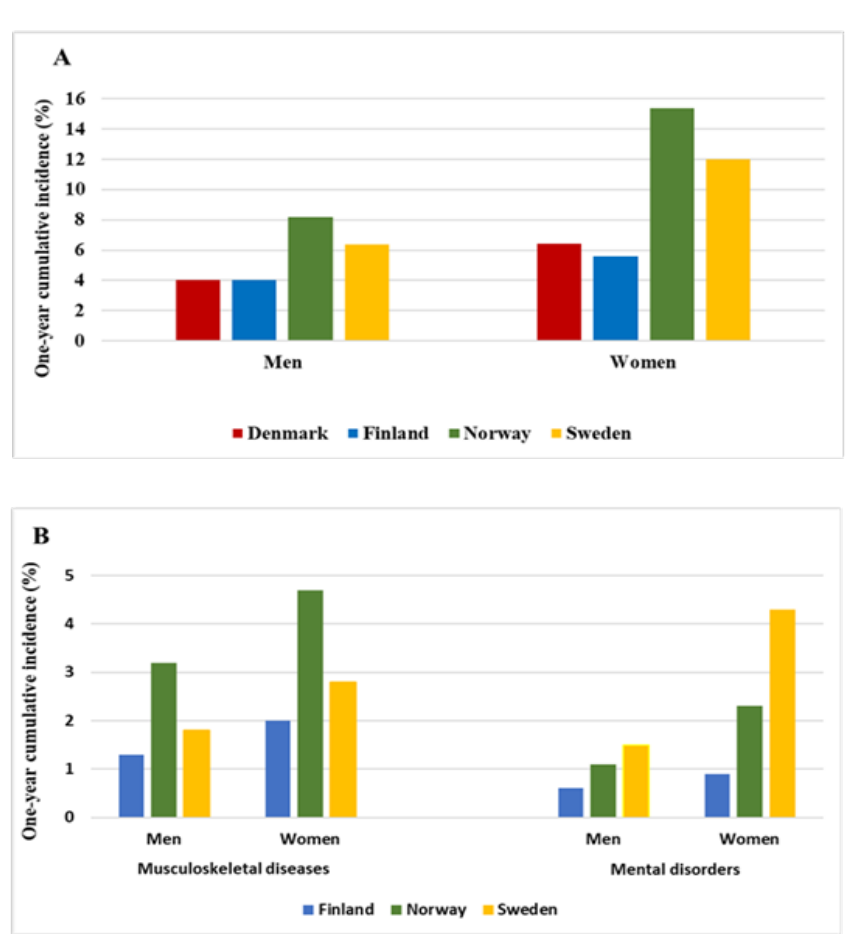
Figure 1. Age-adjusted one-year cumulative incidence of sickness absence among men and women by country, ( A ): Age-adjusted one-year cumulative incidence of all-cause sickness absence; ( B ): Age- adjusted one-year cumulative incidence of cause-specific sickness absence.